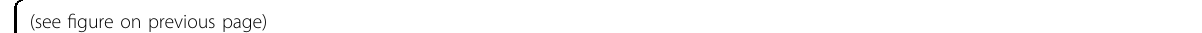
Fig. 2 aSA3-Fc is affected by mutations in the Omicron RBD. a , b SPR binding kinetics of aSA3-Fc to SARS1 RBD ( a ) and WT SARS2 RBD ( b ) were monitored by the Biacore 8 K system. The actual responses (colored lines) and the data fi tted to a 1:1 binding model (black dotted lines) are shown. c The neutralizing activities of aSA3-Fc against SARS1 and WT SARS2. Pseudovirus neutralization assays were performed to characterize the neutralizing activities of aSA3-Fc against SARS1 and WT SARS2 pseudoviruses, while PRNT was conducted to assess the neutralizing activities of aSA3- Fc against authentic WT SARS2. d ELISA results for the binding of aSA3-Fc to the RBD of WT SARS2 and its major variants. EC 50 values were calculated by fi tting the OD 450 values to a sigmoidal dose-response curve and shown in the brackets. e – g SPR binding kinetics of aSA3-Fc to the RBD of Omicron BA.1 ( e ), BA.2 ( f ), and BA.5 ( g ). The actual responses (colored lines) and the data fi tted to a 1:1 binding model (black dotted lines) are shown. h The structure of aSA3:SARS1 RBD complex superimposed on the structure of SARS2 RBD (PDB: 6M0J). The six mutation sites shared by the RBDs of Alpha, Beta, Gamma, Kappa, Lambda, Delta, and Delta plus are marked in blue, the aSA3 footprints are marked in green. i The aSA3 footprints (green) and mutation sites of BA.1, BA.2, and BA.5 (marine) on RBD. j The neutralization properties of aSA3-Fc against authentic Beta, Delta and BA.1. k The neutralization properties of aSA3-Fc against pseudotyped BA.1, BA.2, and BA.5. The IC 50 values were calculated by fi tting the inhibition rates against antibody concentrations with a sigmoidal dose-response curve. Error bars indicate the means ± SD from three (pseudovirus) or two replicates (authentic virus). l R408S mutation present on BA.2 and BA.5 (R408 of SARS2 RBD corresponds to R395 of SARS1 RBD) may reduce the binding of aSA3 to the α -helix on the concave surface of RBD. Black dotted lines indicate hydrogen bonds and salt